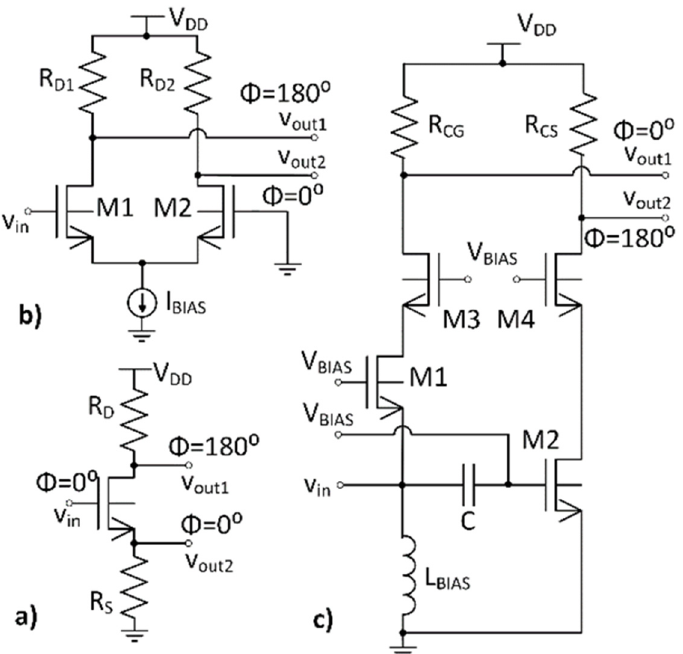
Figure 2. Schematic diagrams of active baluns: ( a ) single MOS transistor balun; ( b ) differential balun; ( c ) common-gate–common-source (CG-CS) balun.